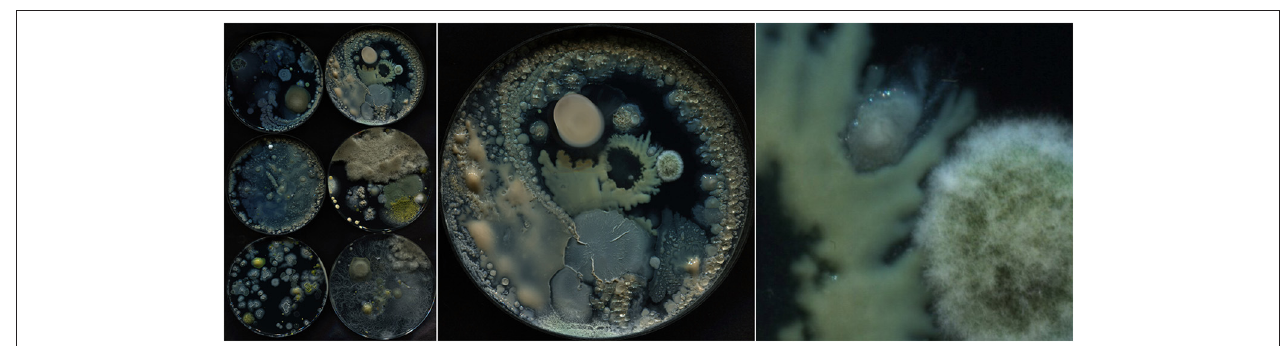
FIGURE 4 | One 13,000 × 9,000-pixel full capture of our scanner that shows microbial cultures in six Petri dishes (Left) . The top-right Petri dish cropped from the full capture, resulting in a 4,200 × 4,200-pixel image of the single dish (Middle) . Cropped 512 × 512-pixel section of the selected Petri dish showing further structural detail of the growing cultures (Right)